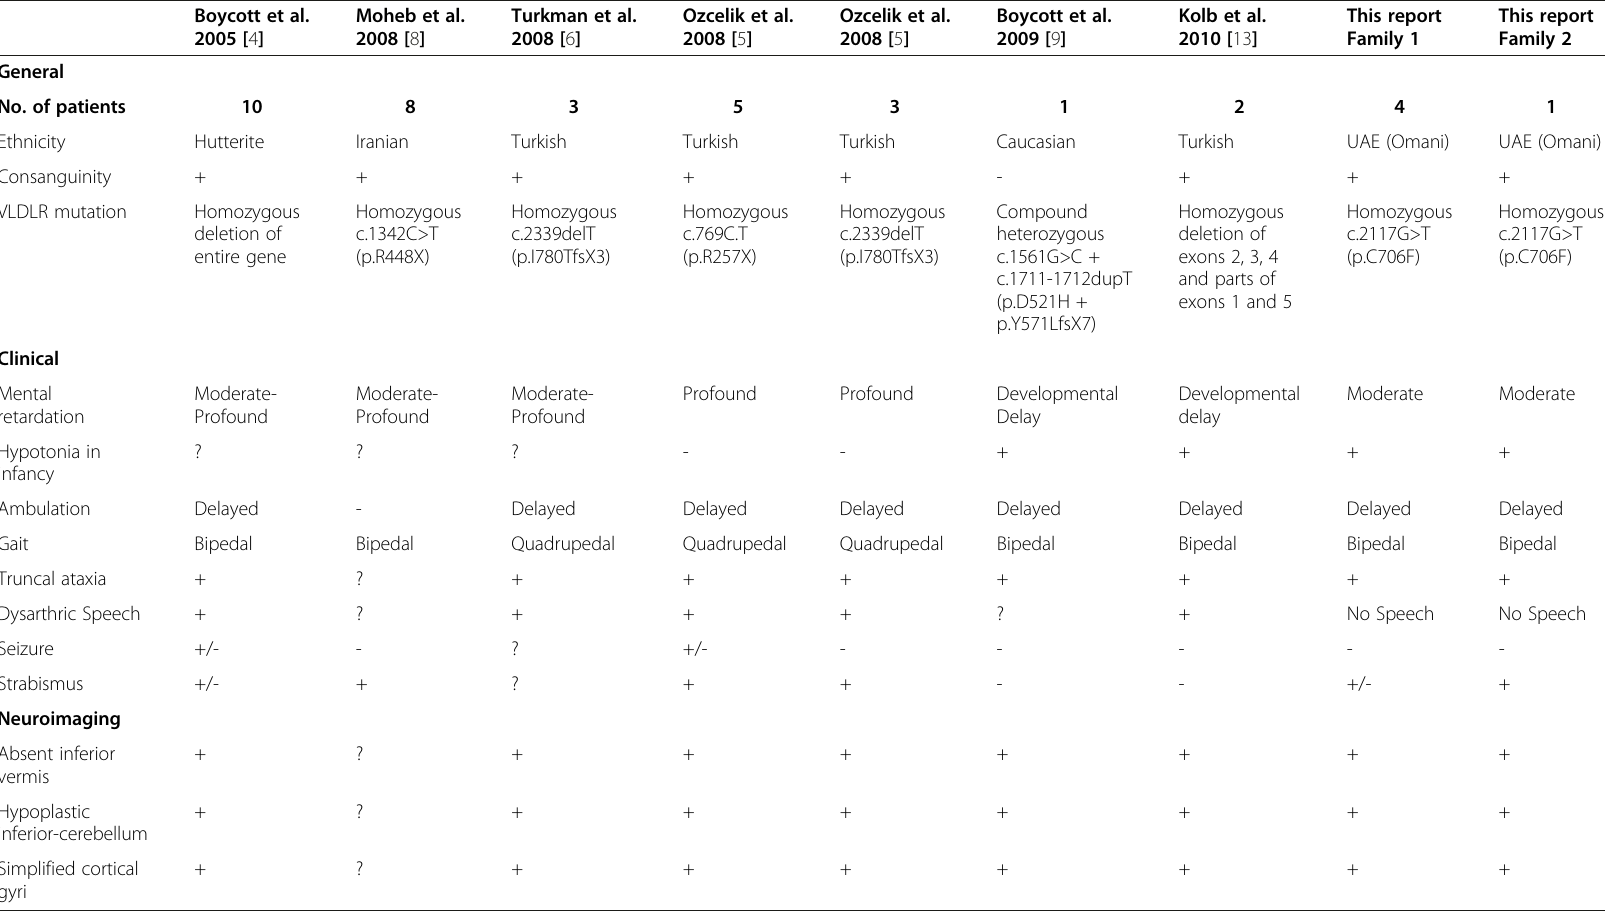
Table 1 Summary of the clinical and molecular features of the reported cases with Dysequilibrium Syndrome- VLDLR